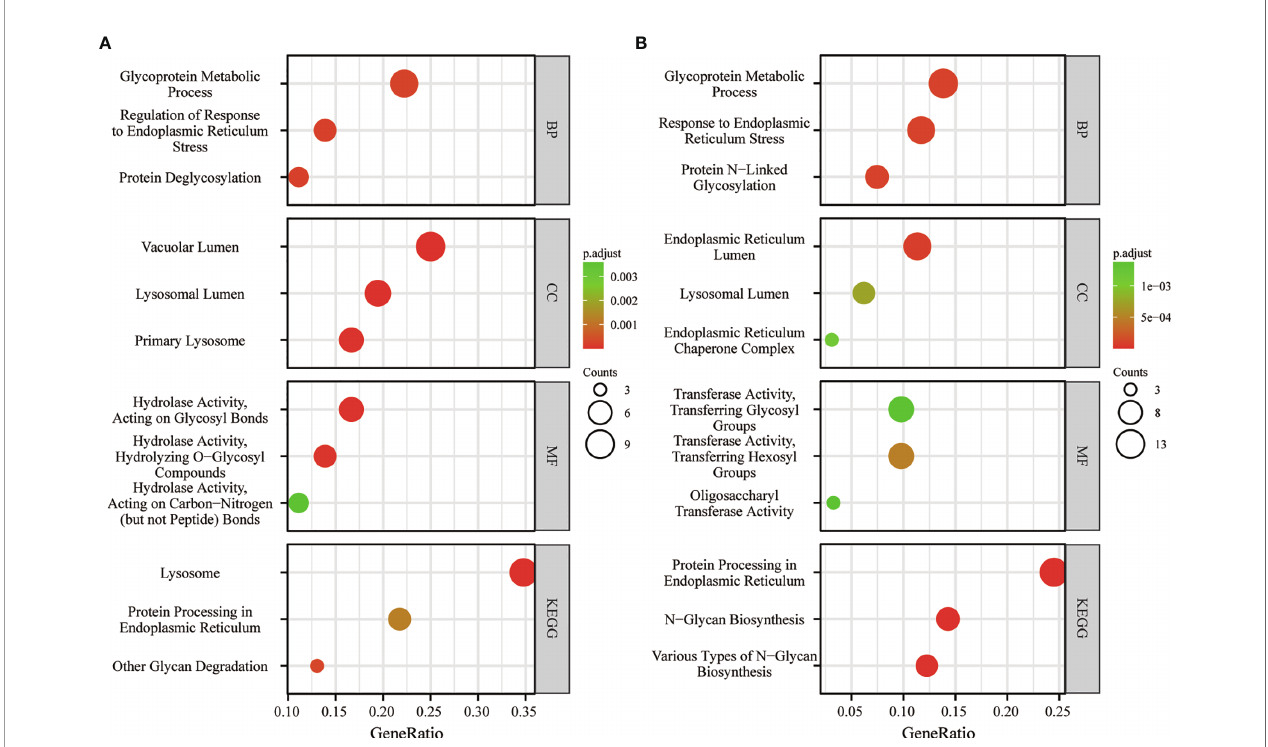
FIGURE 6 | The KEGG analysis of FUCA1 (A) and FUCA2 (B) . KEGG, The Kyoto Encyclopedia of Genes and